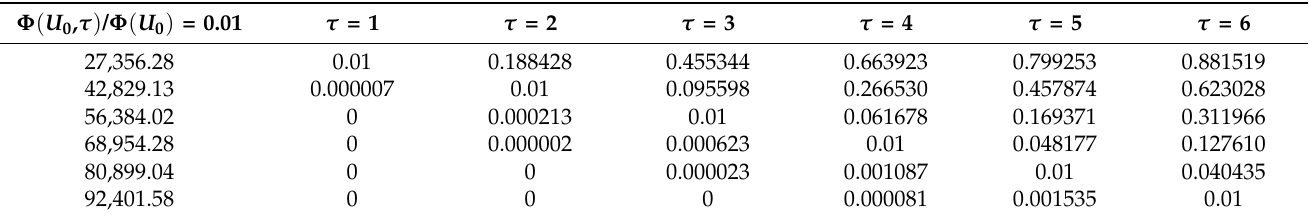
Table 2. Relationship between the initial reserves and the ruin probability expressed by means of Brownian motion. Φ ( U ) / Φ ( U ) = 0 , τ 0